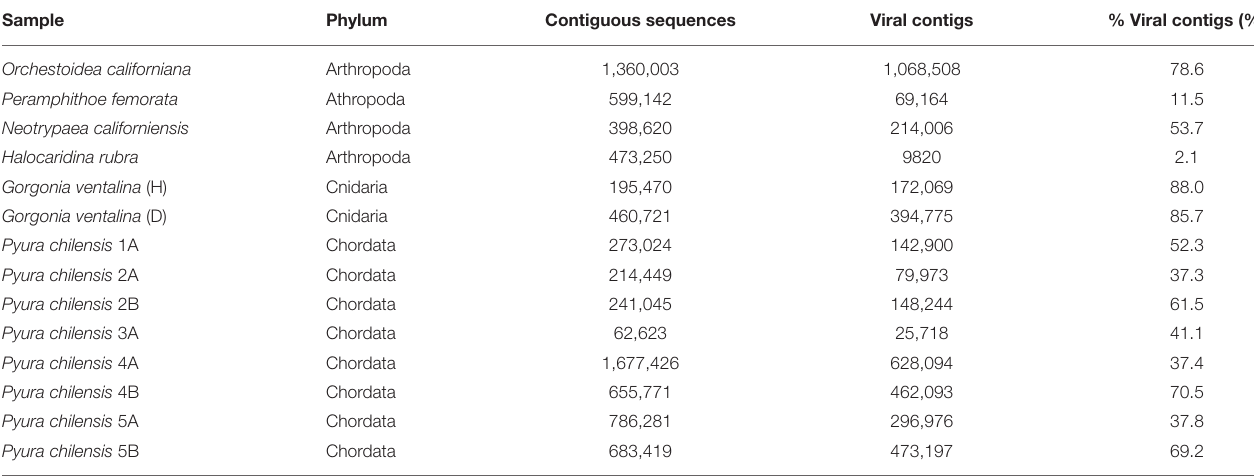
TABLE 2 | The number of contiguous sequences (viral, bacterial, archaeal, eukaryotic), annotated viral contigs, and percentage of viral contigs resulting from the sequencing of viromes from samples listed in Table 1.